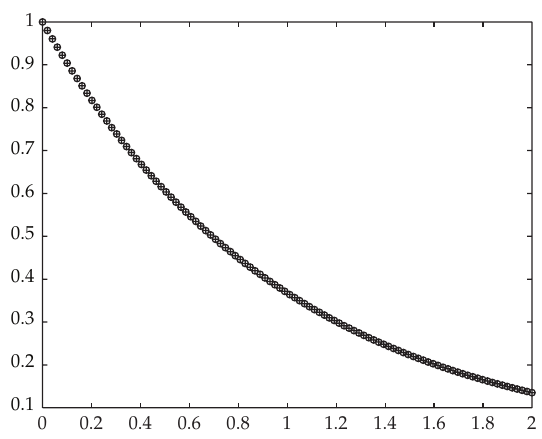
Figure 9: Index 3, T (cid:8) 2, the z 2 -coordinate, “o”-original, “ (cid:9) ”-approximation.